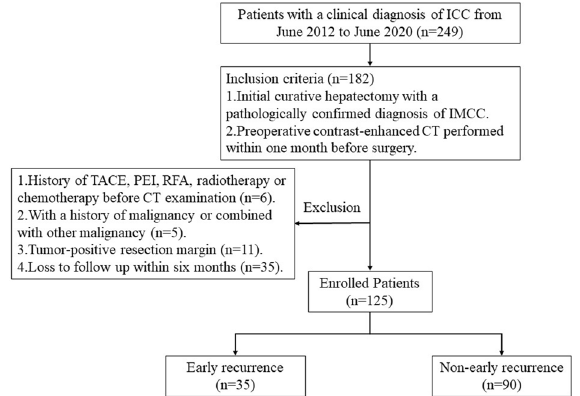
Figure 1. Flow chart showing inclusion and exclusion of subjects for this study. ICC intrahepatic cholangiocarcinoma, IMCC intrahepatic mass-forming cholangiocarcinoma, TACE transarterial chemoembolization, PEI percutaneous ethanol injection, RFA radiofrequency